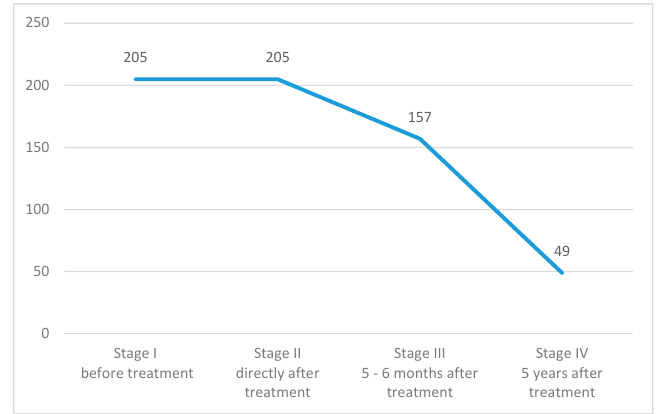
Figure 1. Number of women taking part in each stage of the study. Table 1. Socio-demographic characteristic of the study group.